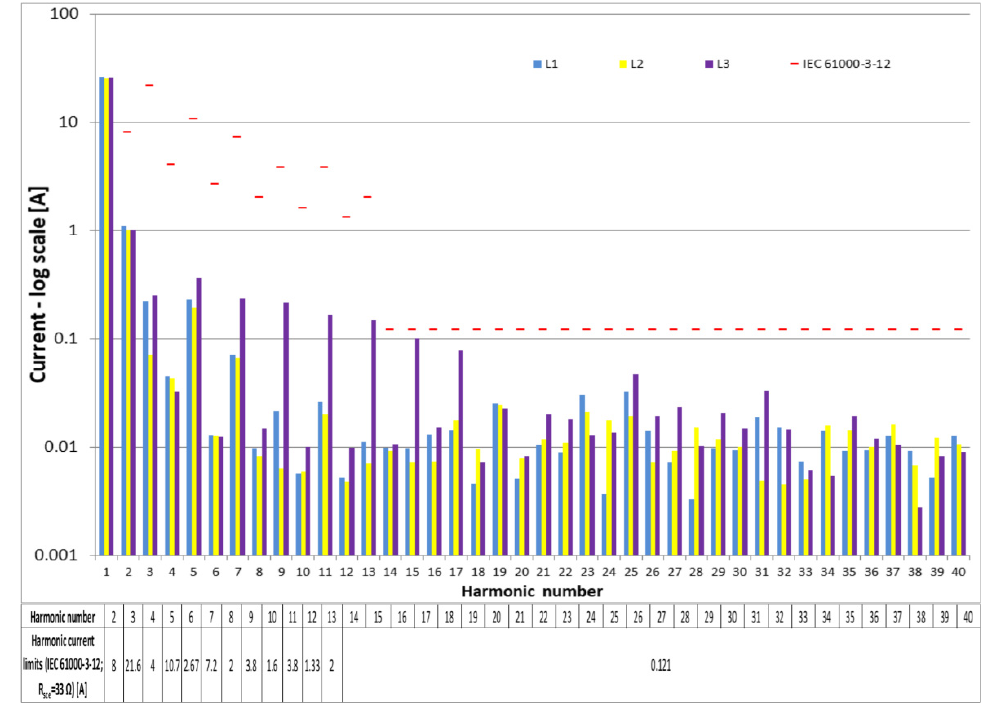
Figure 8. The harmonic current spectrum of a DC module (80% of power).